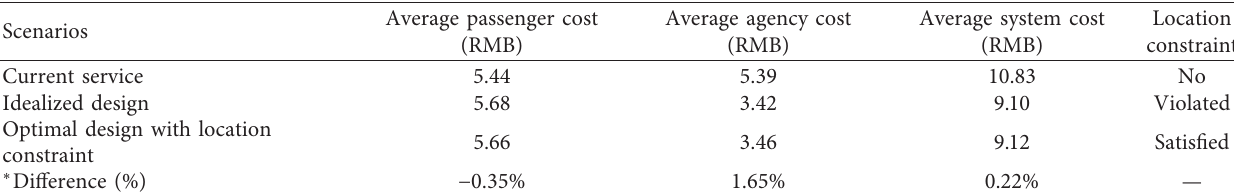
Table 5: Comparison of cost items among different